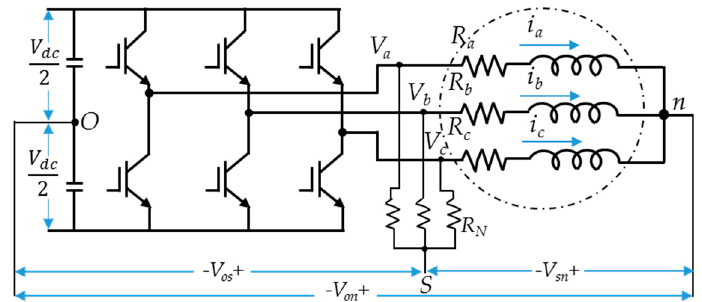
Figure 7. Equivalent circuit of inverter-fed three-phase PMSM with resistor network-based neutral